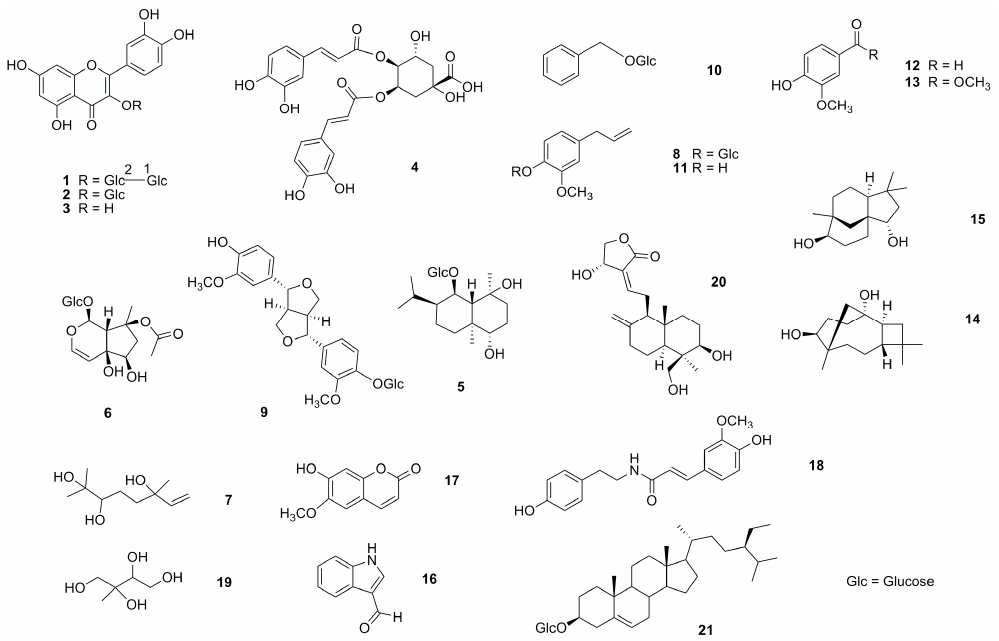
Figure 4. Structures of compounds 1 – 21 isolated from the IBM (compounds 10 – 21 ) and IBB (compounds 1 – 9 ) crude fractions.